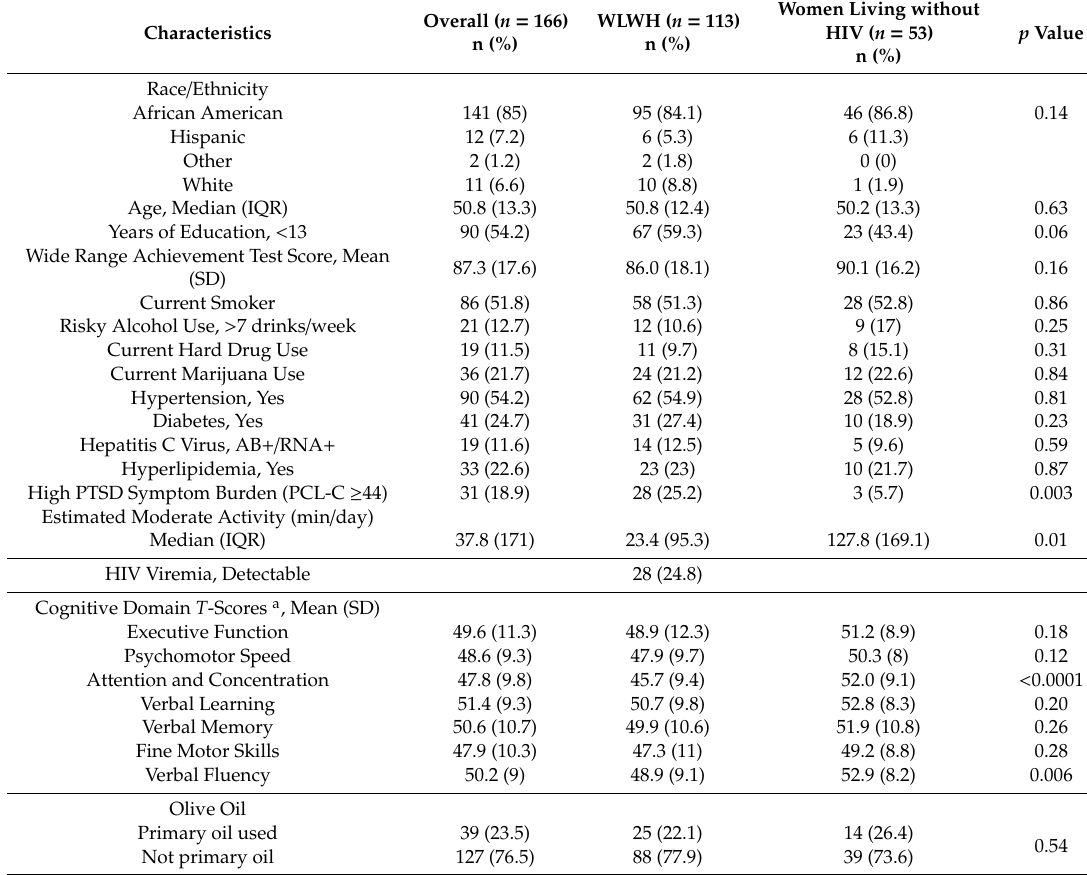
Table 1. Characteristics of Block 2014 food frequency a Chicago WIHS (Women’s Interagency HIV Study) participants by HIV (human immunodeficiency virus) status. ( n =